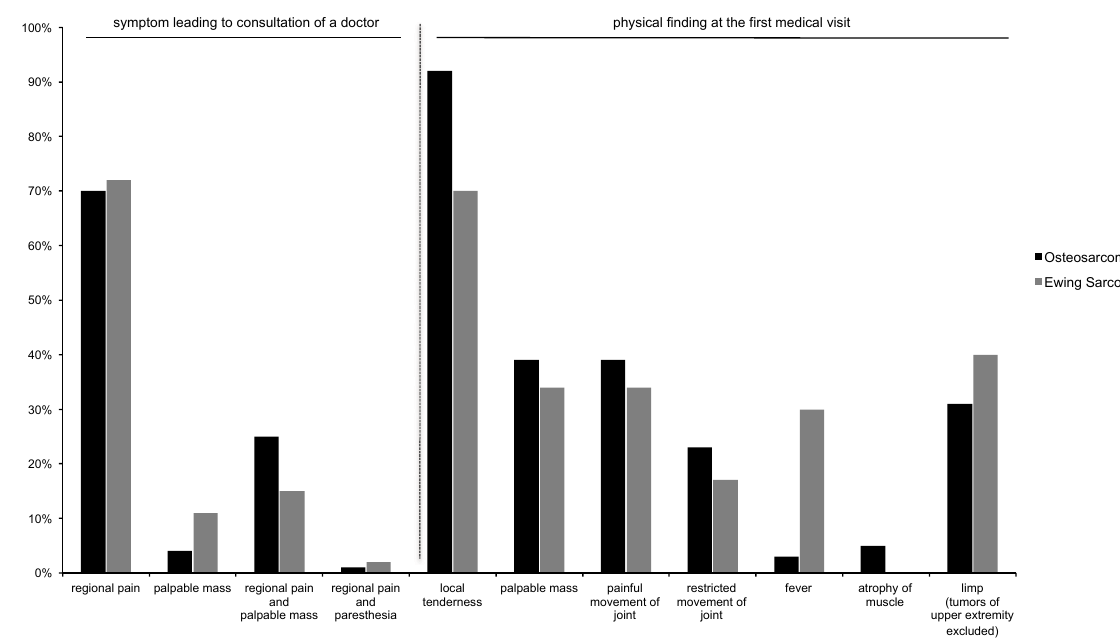
Figure 4. Percentage of symptoms leading to consultation of a doctor, compared to the percentage of physical findings at the first medical visit in case of osteosarcoma and Ewing sarcoma [ 31